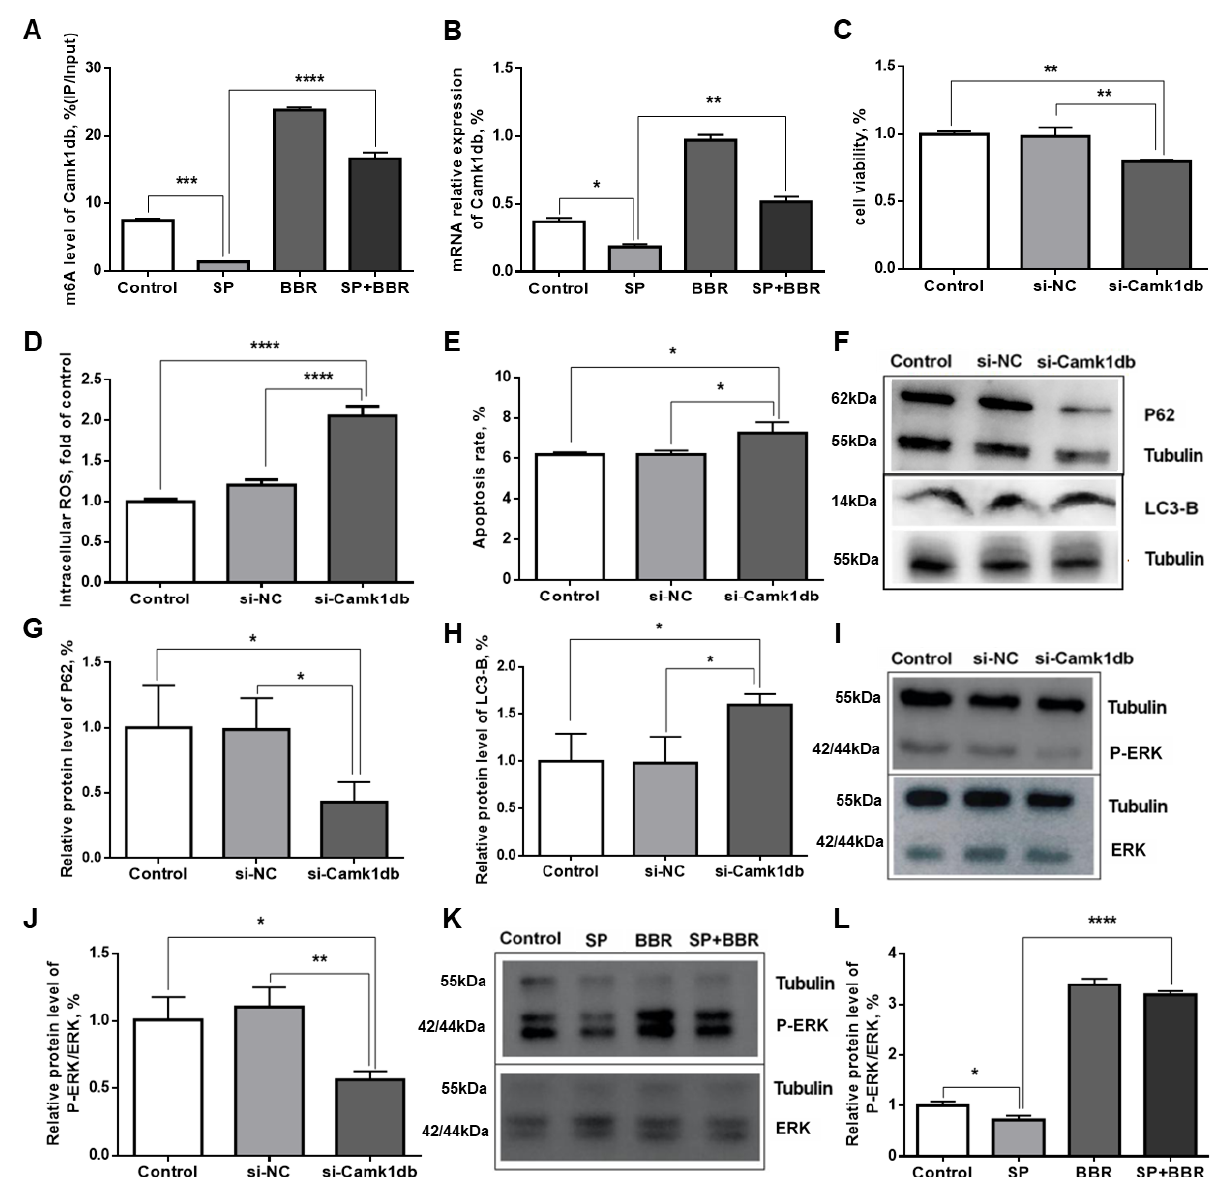
Figure 7. Validation of Camk1db gene methylation and its regulation of cellular homeostasis in ZFL by Camk1db . ( A ) is m 6 A methylation level of Camk1db gene in ZFL. ( B ) is relative mRNA expression of Camk1db gene in ZFL. ( C ) is liver cell activity. ( D ) is the relative expression of intracellular ROS. ( E ) is apoptosis rate. ( F ) is the WB map of LC3-B and P62 protein. ( G ) are relative content of P62 protein. ( H ) are relative content of LC3-B protein. ( I , J ) are the WB map and relative level of P- ERK/ERK protein before and after transfection. ( K , L ) are different treatment groups (Control, SP, BBR, SP + BBR) P-ERK/ERK WB map and relative expression of protein. Dates were presented as